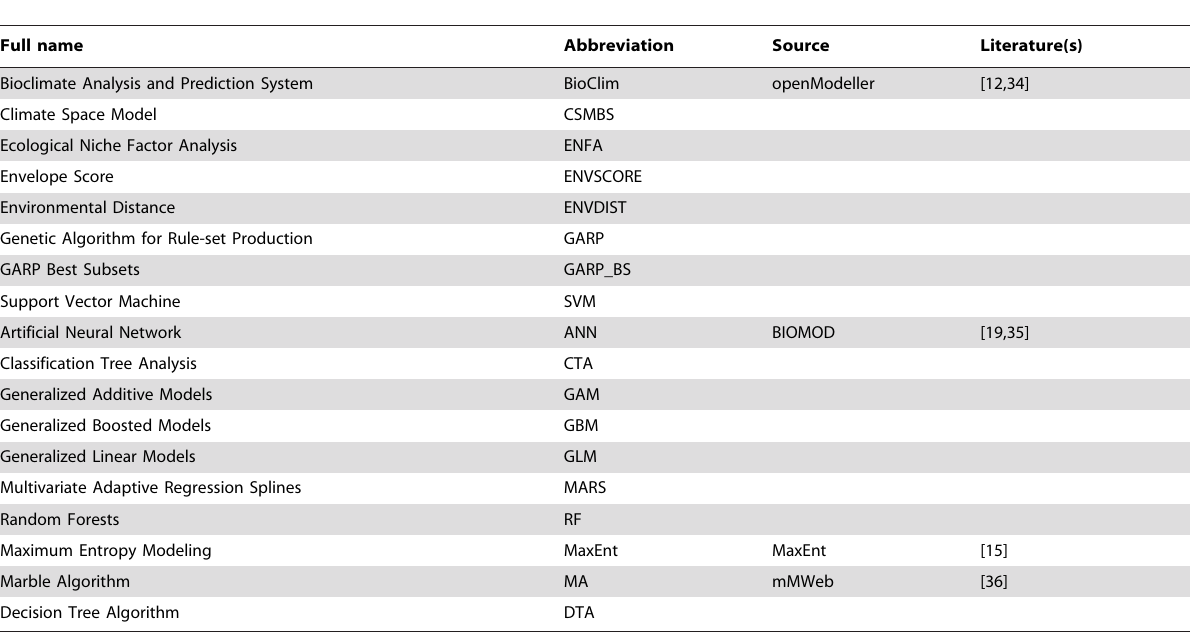
Table 1. ENM platforms and associated algorithms available in